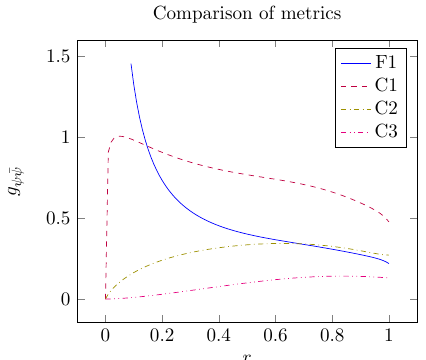
Figure 7 . Metric for the central ’ -value in the (cid:16) (cid:28) 0-phases of C1, C2, C3 and F1.